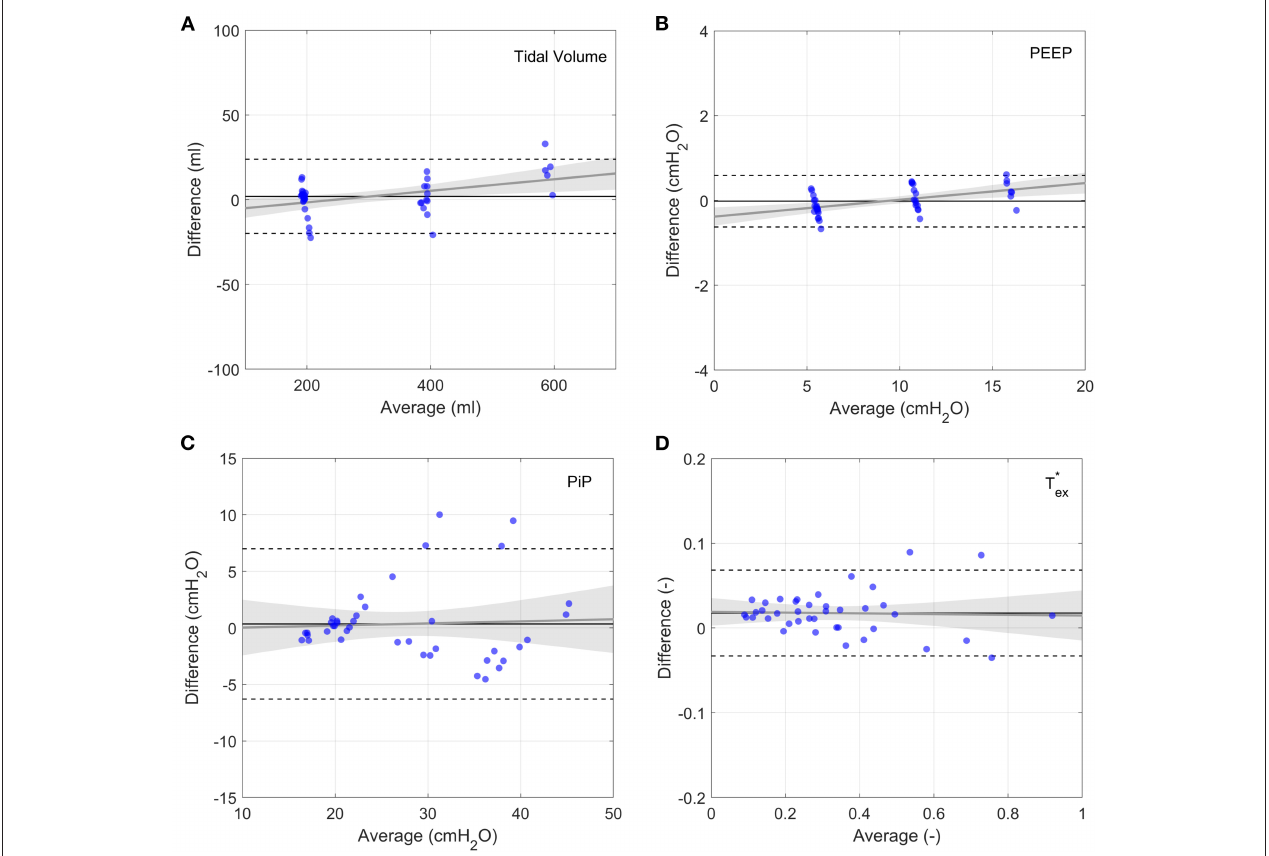
FIGURE 10 | Bland-Altman plots of output parameters between the numerical model and experimental data. Each experimental data point represents the average of 9 breaths, taken 5 breaths after changing a single clinical input. Grey lines show linear fits to the data with the 95% confidence bands indicated by the shaded grey regions. Horizontal solid lines show average difference and dashed lines show plus and minus two standard deviations. (A) Tidal volume, (B) PEEP, (C) PiP, (D) T * ex